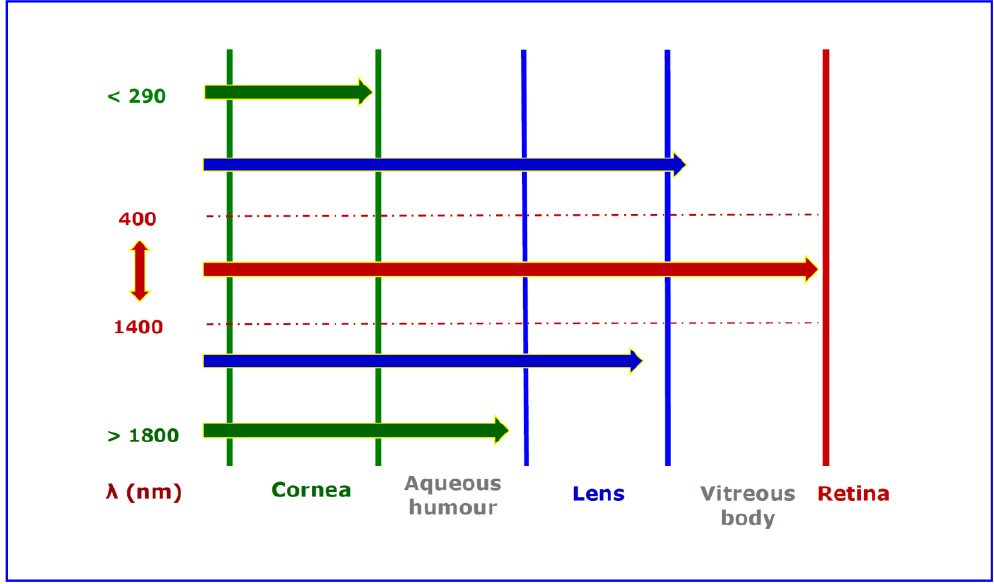
Figure 2. A schematic picture showing the ability of different spectral bands of optical radiation to penetrate eye. It is evident that only visible radiation and IRA (InfraRed A) may reach retinal tissue in physiological